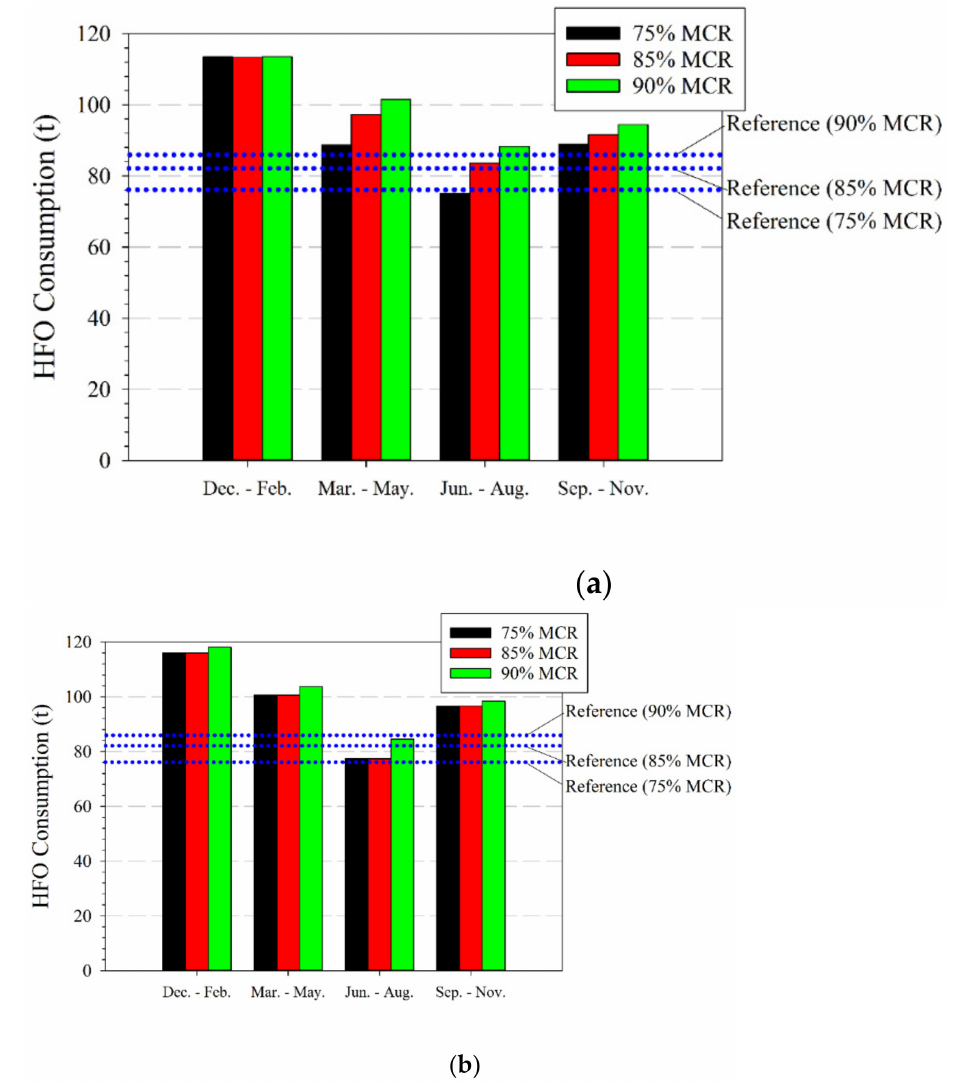
Figure 18. HFO consumption per MCR and per seasons compared with reference lines (blue) of calm waters. ( a ) Load Condition 1. ( b ) Load Condition 2. Source: Own